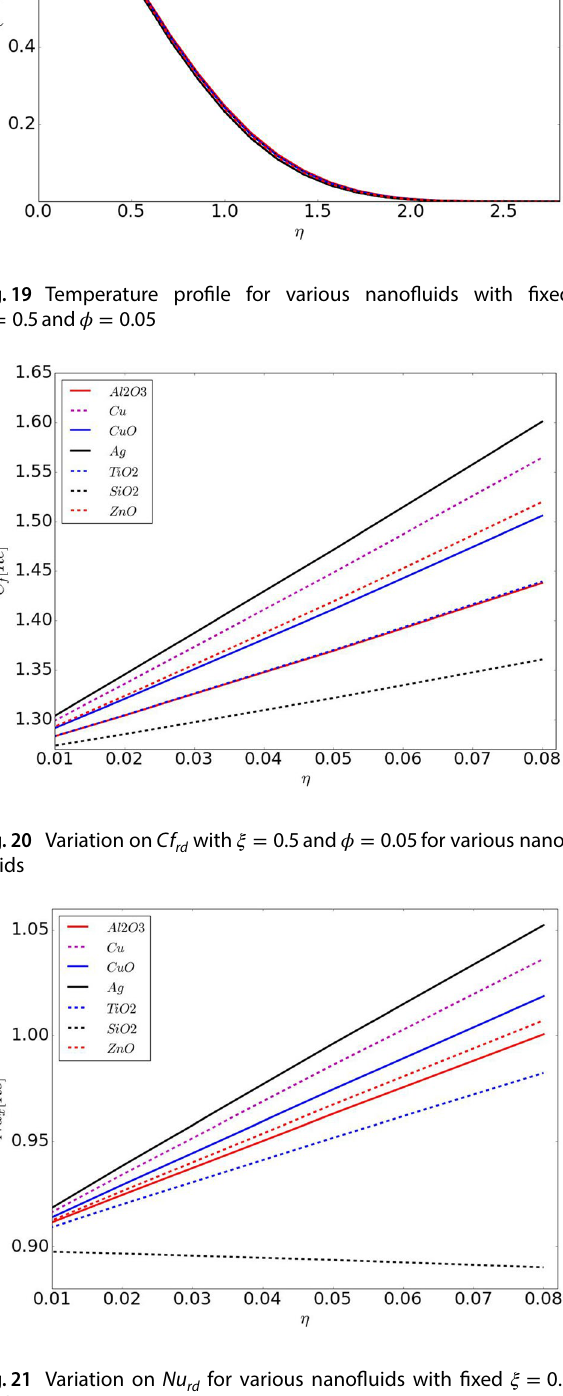
Fig. 21 Variation on Nu rd for various nanofluids with fixed 𝜉 = 0.5 and 𝜙 =